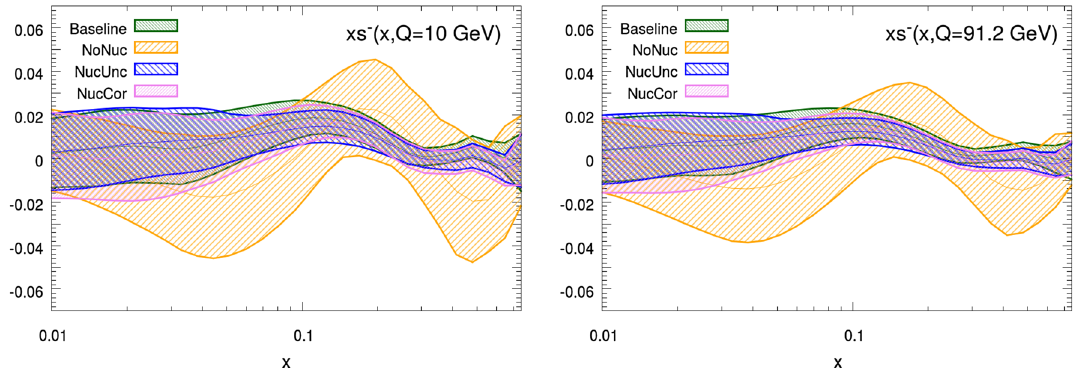
Fig. 14 The fraction R s , Eq. (13), as a function of x at two representative values of Q for the nuclear data ( Q = 1 . 38 GeV) and for the ATLAS W Z data ( Q = 91 . 2 GeV)